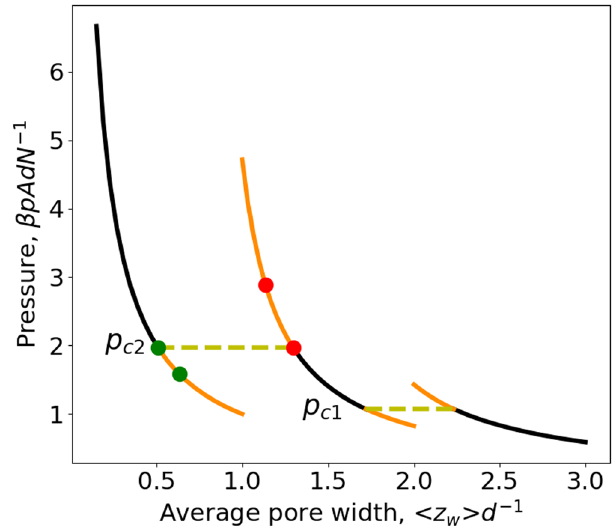
Fig. 5 | Isobaric-isothermal Monte-Carlo simulation results. Evidence for the hysteresisinthecompression-expansionisothermforanidealgascon fi nedinaslit pore (computational conditions and details are given below in Methods section). Repulsive square-well gas-wall potential ( ε <0) at a reduced temperature, T =0 : 9525 ∣ ε ∣ k B (cid:1) 1 ð e βε =0 : 35 Þ . pTN -ensemble Monte-Carlo simulation results: red dots (obtained in a compression process), green dots (obtained in an expansion process); Exact analytical result given by Eq. (29): lines (the same results as those shown in Fig. 3).